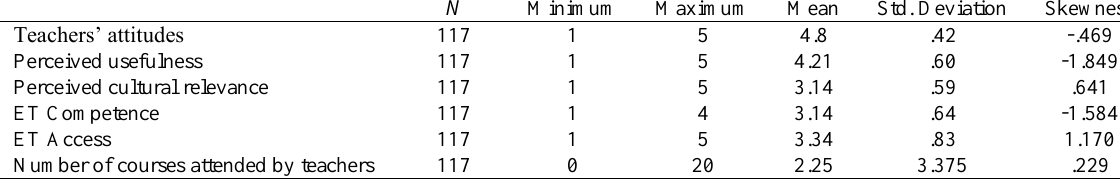
Table 2 Descriptive statistics on teachers’ attitudes and related factors